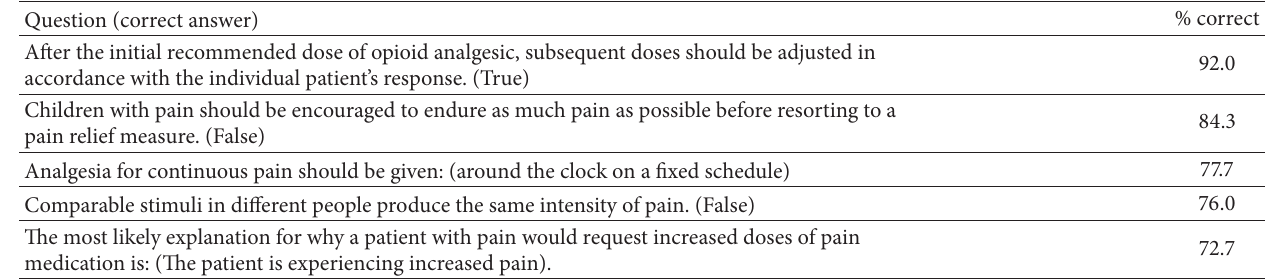
Table 6: Top 5 questions answered correctly by nursing